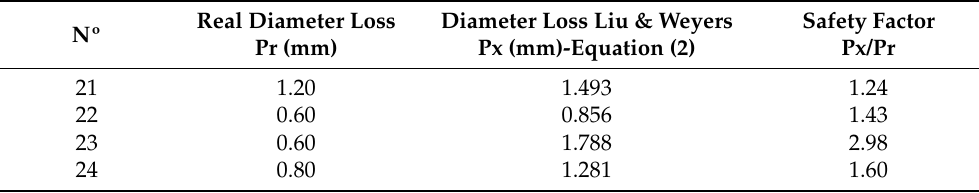
Table 5. Case studies with favourable results using the Liu & Weyers (1998) model.